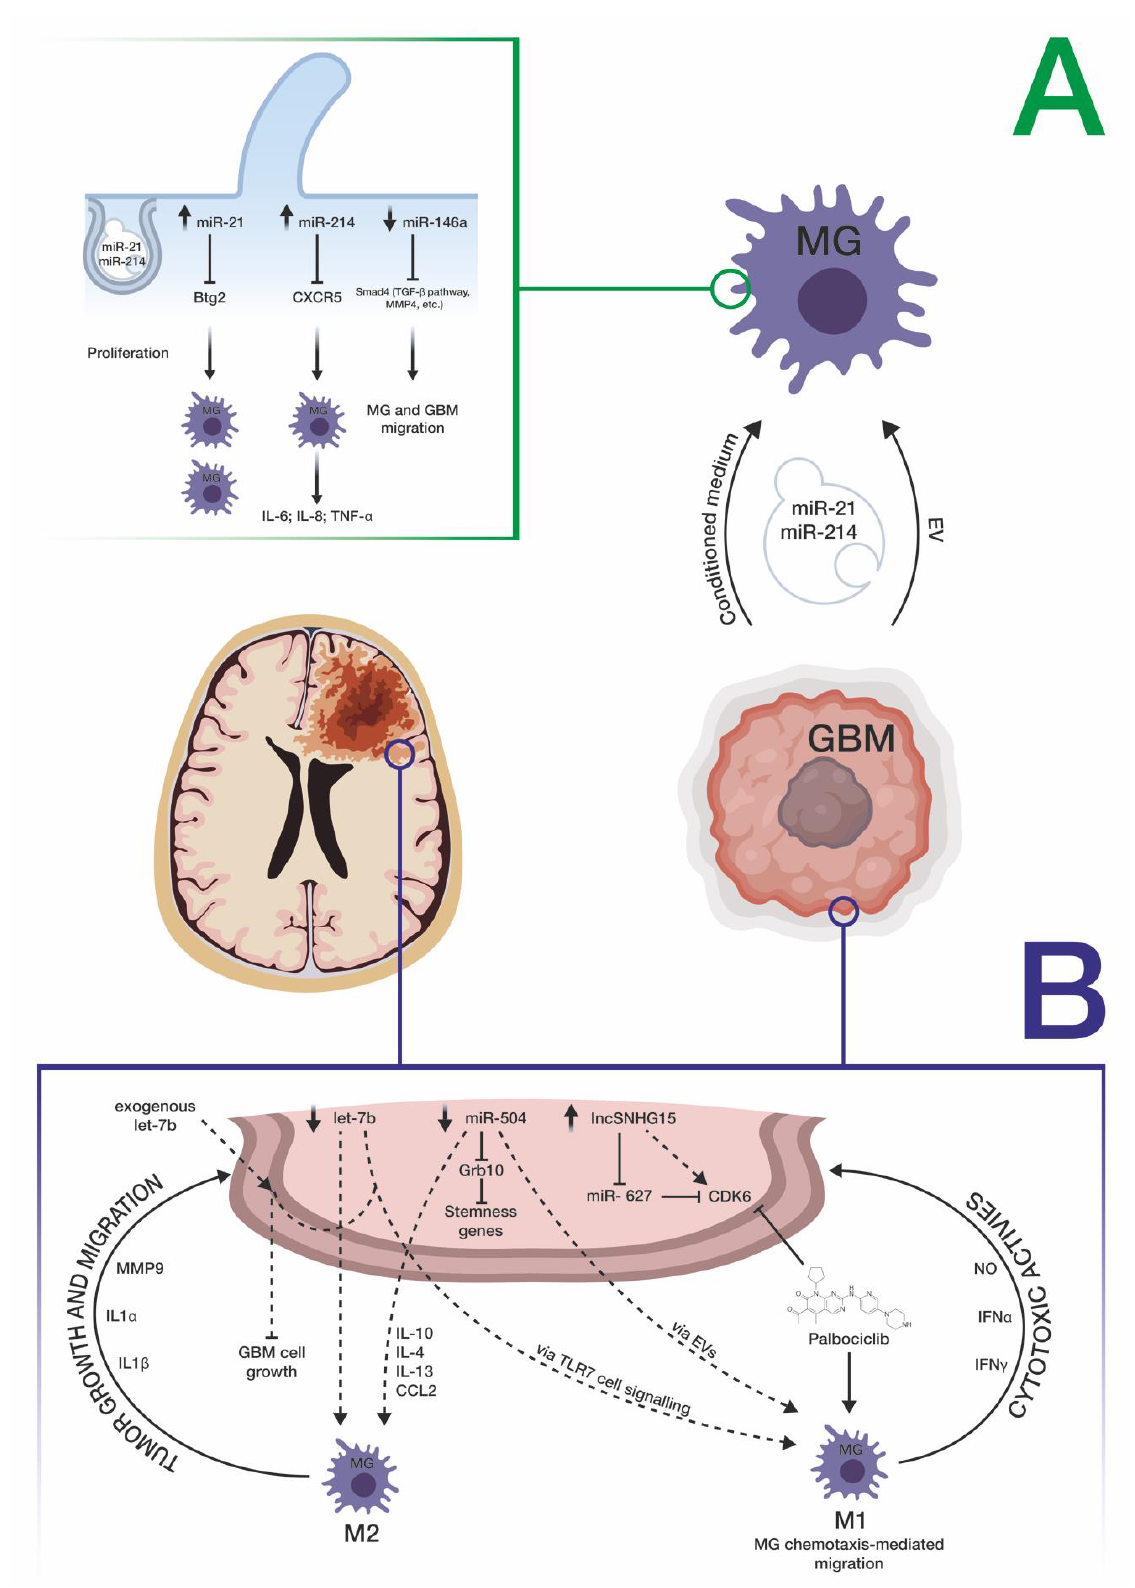
Figure 2. Schematic representation of miRNA-mediated cross-talk between GBM and microglia cells. ( A ) Effects of the cross-talk between GBM and microglia in pathological conditions, inducing microglial M2 polarization. ( B ) Suggested miRNA-mediated therapeutic strategies inducing the switch from M2 to M1 microglial polarization. Refer to the text for a more detailed description. MG = microglia; GBM = glioblastoma .